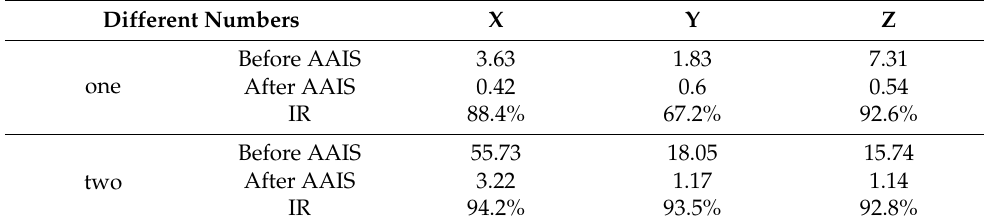
Table 10. The standard deviation (nT) with different motor